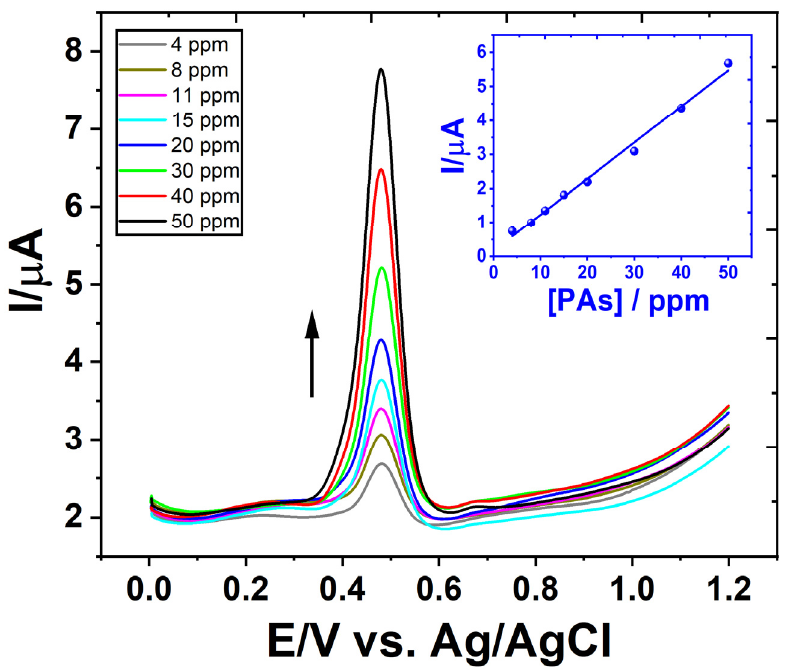
Figure 5. SW voltammograms obtained on GCE in B-R buffer (pH 1.8) solution containing different concentrations of PAs at frequency 10 Hz, pulse amplitude 25 mV, and pulse width 1 mV. Inset: Calibration plots of oxidation peak current against the applied concentration of PAs on GCE. Table 1. A comparison of this protocol with other protocols using catechin as a model compound.